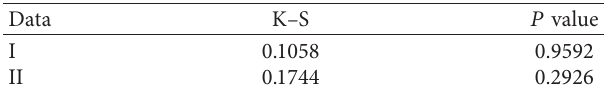
Table 3: Results of goodness-of-fit tests for fitting GE distribution to two datasets.